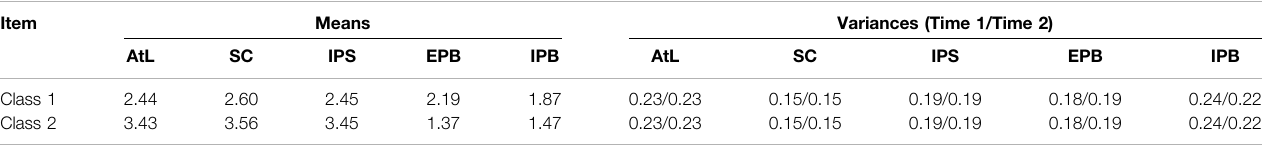
TABLE 2 | ECLS-K 2-class model of social rating scale measurement